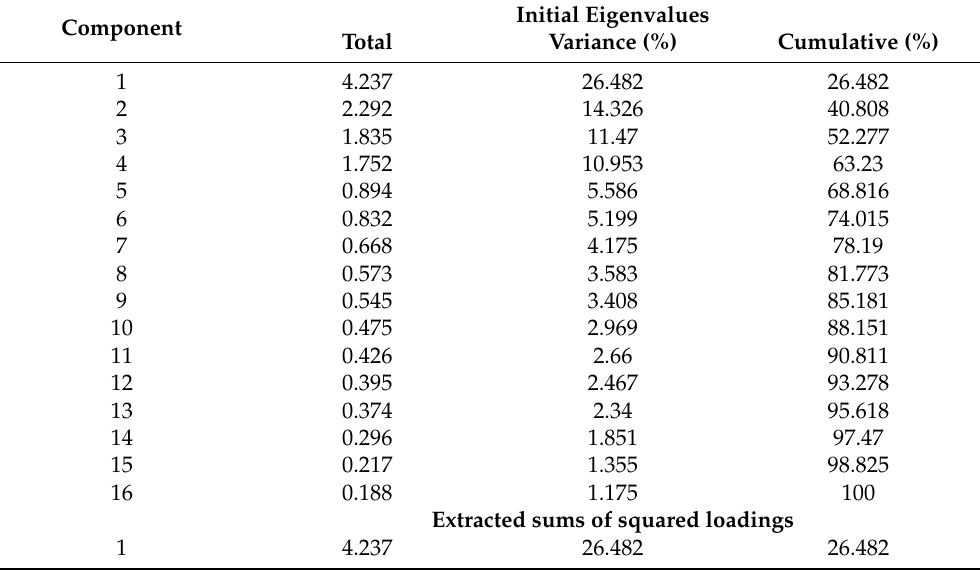
Table 2. Total variance explained.